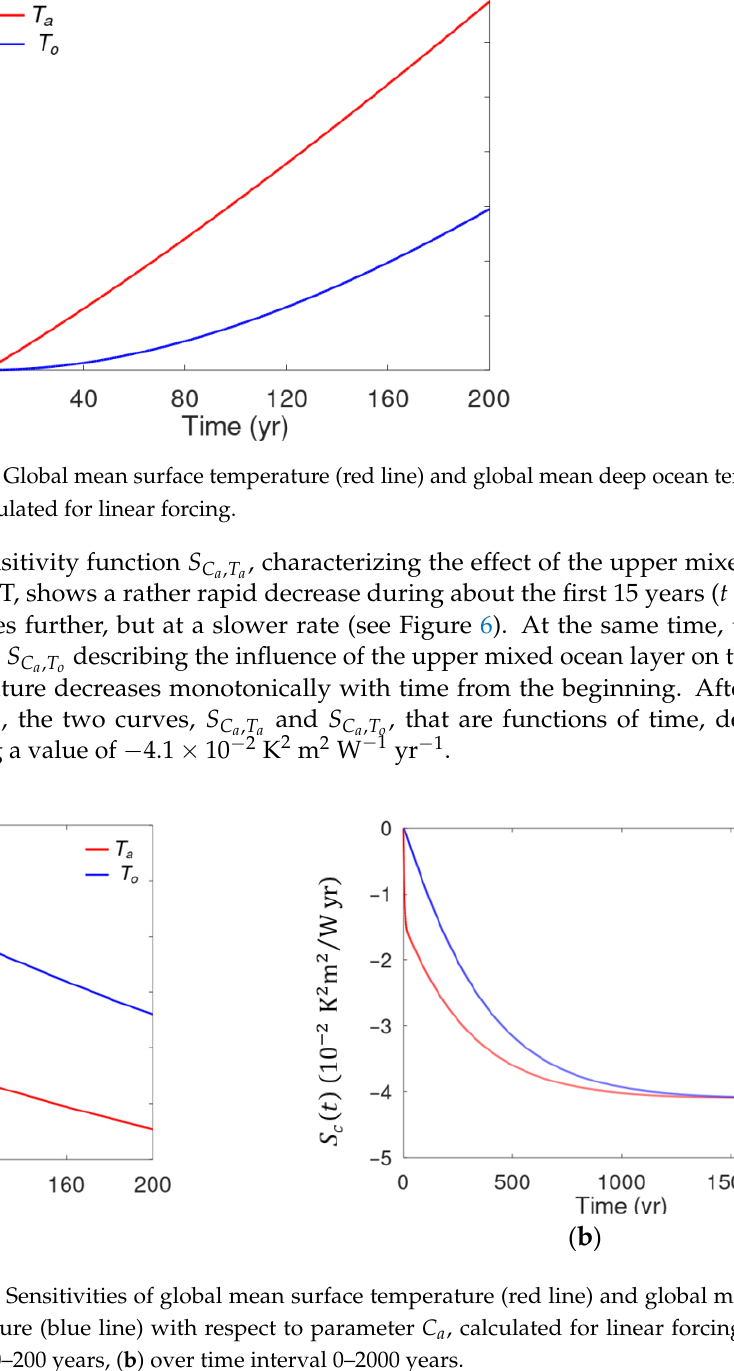
Figure 7. Sensitivities of global mean surface temperature (red line) and global mean deep ocean temperature (blue line) with respect to parameter 𝐶 (cid:3042) , calculated for linear forcing: ( a ) over time interval of 0–200 years, ( b ) over time interval of 0–2000 years.